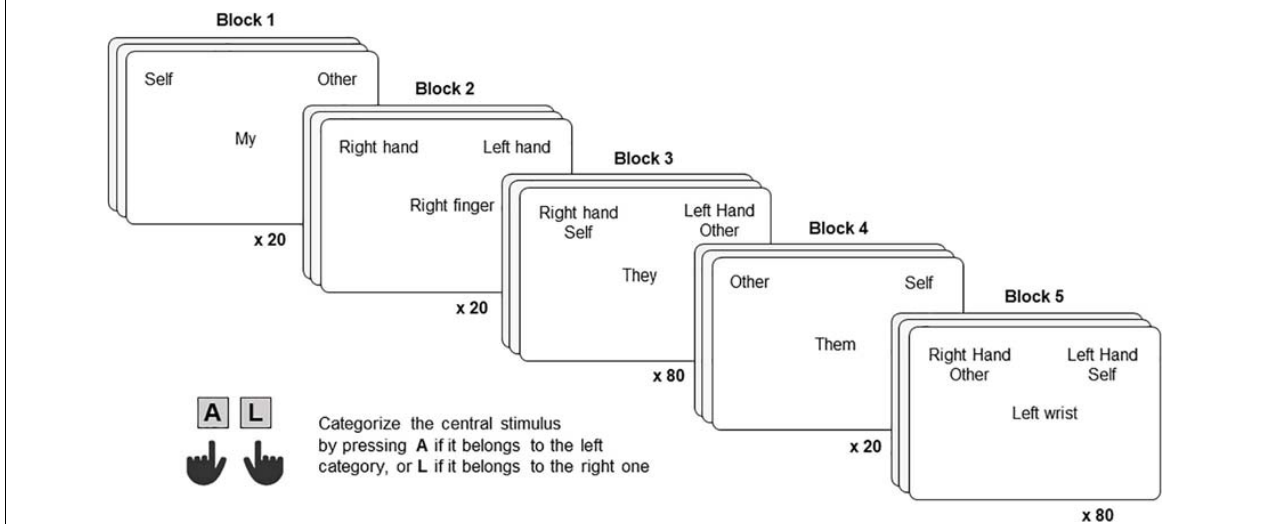
FIGURE 2 | For each block of the Human Body Part condition, one exemplificative trial is represented. In each trial, participants were required to categorize the word displayed at the center as belonging to the leftward or rightward category, by pressing the “A” or “L” key, using their left or right index finger, respectively.